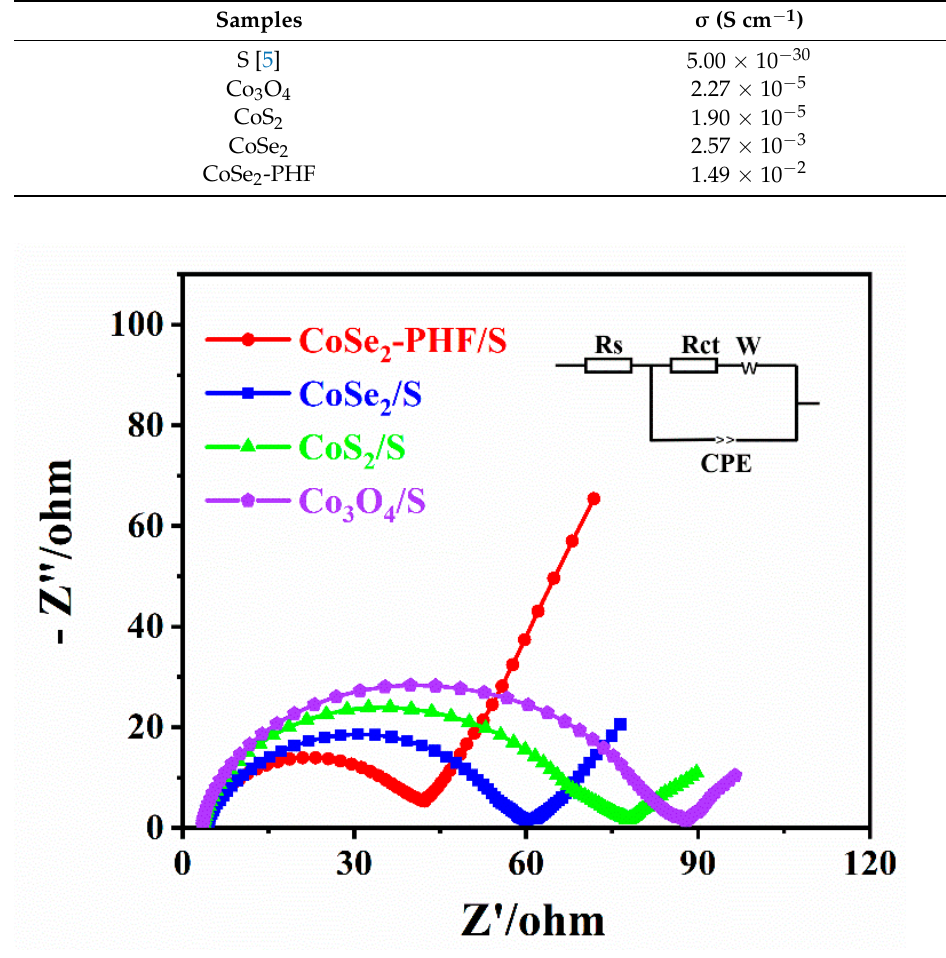
Figure 6. Electrochemical impedance spectra of CoSe 2 -PHF/S, CoSe 2 /S, CoS 2 /S, and Co 3 O 4 /S cathodes. To further study the electrochemical performance of CoSe 2 -PHF/S electrodes, a series of charge-discharge cycling experiments were tested. As shown in Figure 7a,b, CoSe 2 - PHF/S electrodes showed much higher discharge capacity than CoSe 2 /S electrodes at any discharge voltage. In Figure 7c, the ratio of Q2 (Corresponding to Li 2 S 4 + 2e − + 2Li + → 2Li 2 S 2 ; Li 2 S 2 + 2e − + 2Li + → 2Li 2 S) to Q1 (Corresponding to S 8 + 4e − + 4Li + → 2Li 2 S 4 ) for CoSe 2 -PHF/S and CoSe 2 /S electrodes were 2.64, and 1.63, respectively.